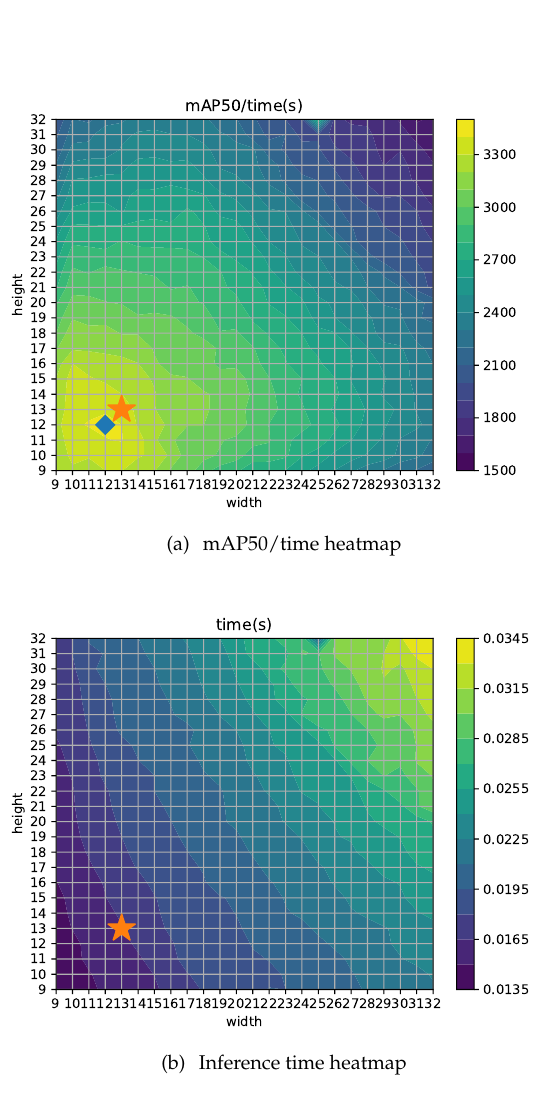
Figure 9. YOLOv4: heatmaps for inference time and mAP50/time ratio for different width and height grid configurations. Table 7. YOLOv4 AP50 for each class with different activation functions, data augmentation techniques, and grid size configurations (BDD100K trained and applied to the BDD100K test